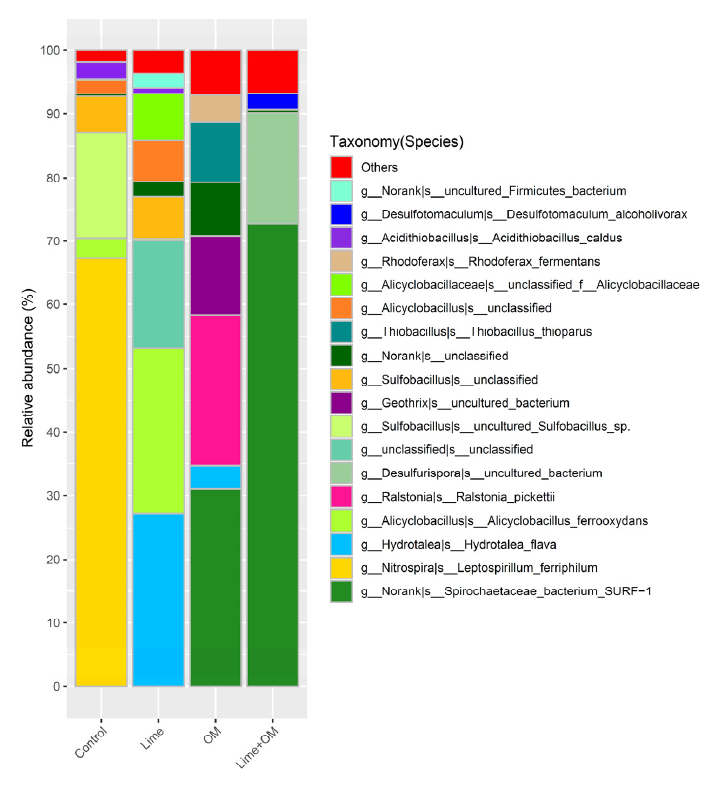
Figure 3. Species of the microbial community in the solution phase of the four columns (control, Lime, OM, and Lime + OM) at day 150.